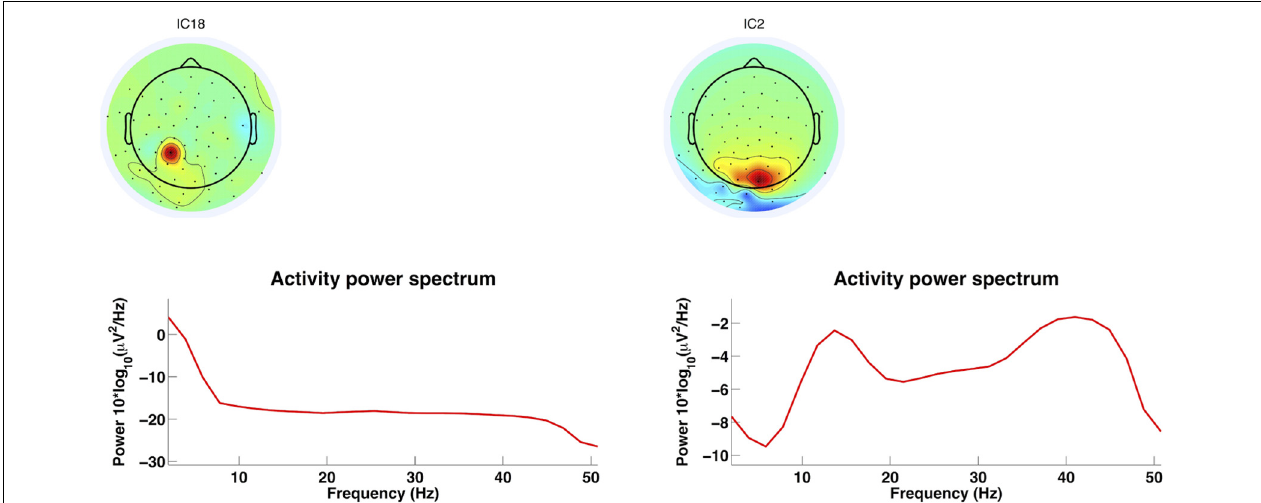
FIGURE 12 | AMICA decomposition components. This figure shows two components from an AMICA decomposition using EEGLAB for the plots. Left: Centrally localized component shows higher power content in lower frequencies and a drastic reduction at frequencies above 30Hz. Right: